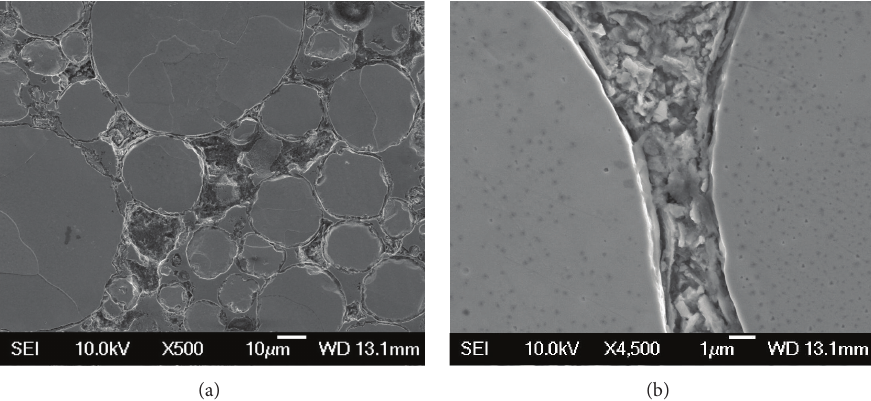
Figure 8: (a) and (b) SEM images displaying a cross section from the sintered FeSi/Mn 0.8 Zn 0.2 Fe 2 O 4